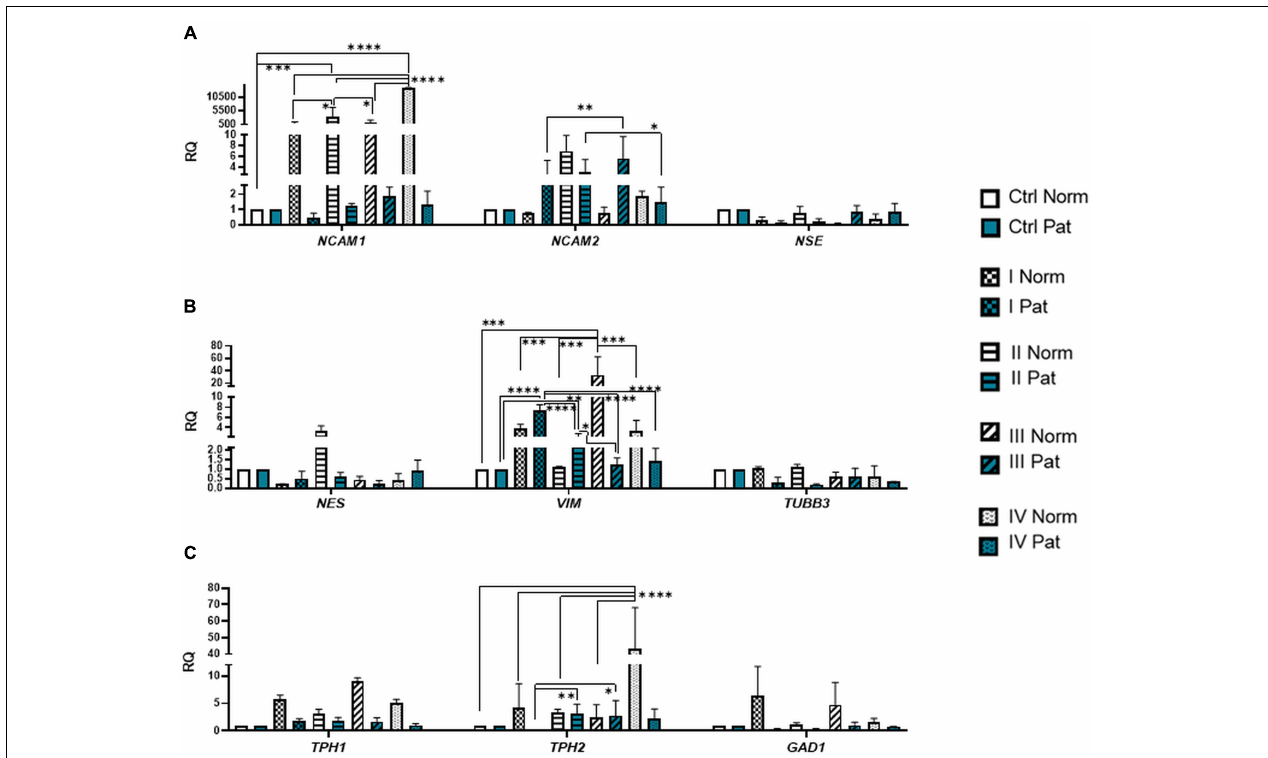
FIGURE 5 | Gene expression profile of neuronal markers, neurotransmitter-producing enzymes, and cytoskeletal proteins in hAFSCs from normal and fetus-affected gestations induced to neuronal differentiation. RT-qPCR analysis of hAFSCs (A) neuronal markers NCAM1 , NCAM2 , and NSE ; (B) cytoskeletal protein genes NES , VIM , and TUBB3 ; and (C) neurotransmitter-producing enzyme genes TPH1 , TPH2 , and GAD1 . Gene expression analysis was performed using control hAFSCs (not treated, Ctrl) and neuronal differentiation-induced hAFSCs (treated for 72 h with I–IV differentiation protocols; see Table 1 in section “Materials and Methods”) from normal (Norm, n = 3) and fetus-pathological (Pat, n = 3) gestations. RT-qPCR data are represented as relative fold change over undifferentiated control, normalized for the housekeeping genes GAPDH and RPL13A ; values are indicated as mean ± SD. *Denotes significant difference with p < 0.05, **denotes significant difference with p < 0.01, ***denotes significant difference with p < 0.005, and ****denotes significant difference with p < 0.0001, as evaluated using one-way ANOVA with Tukey’s post hoc